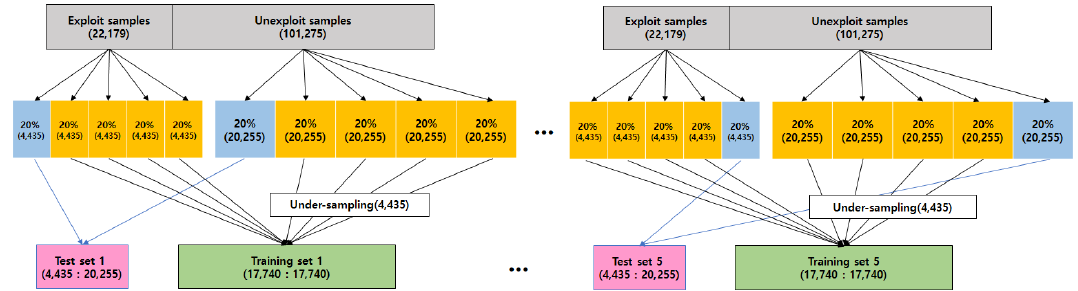
Figure 4. Training and test set